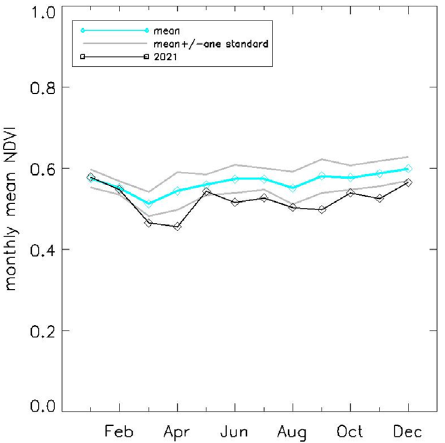
Figure 7. The time series of NDVI presented in the same format as Figure 6.